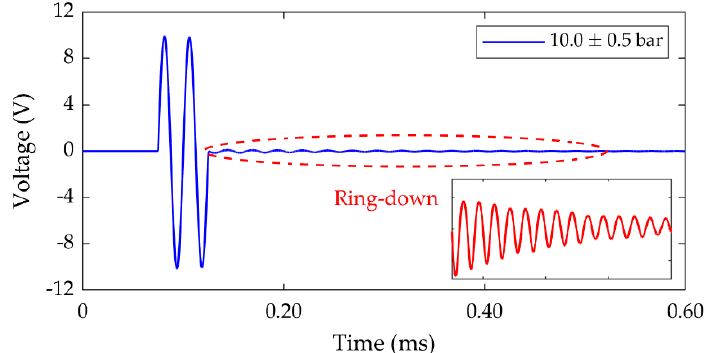
Figure 10. A typical example of a 𝑇 (cid:3025) signal used in this study, showing the resonant ring-down phenomenon in the signal immediately after the cessation of the cycle burst. The ring-down is scaled for clarity shown by the inset figure.